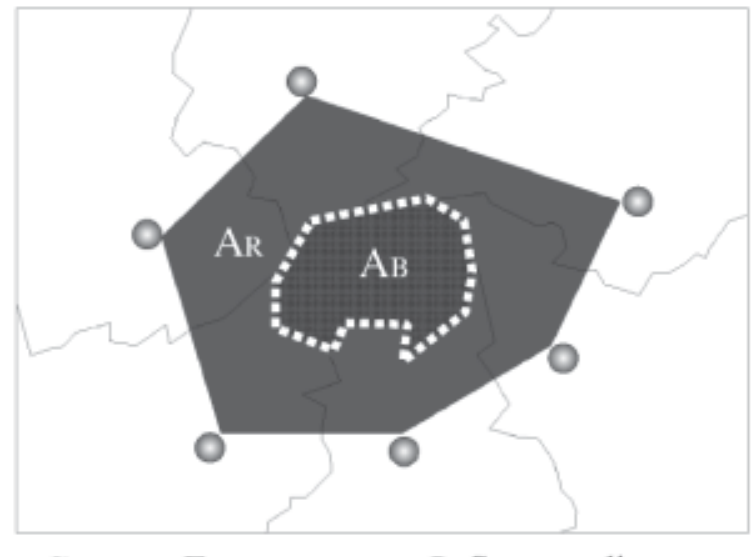
Fig. 1. Illustration of the ground projection of a canopy gap. The area of the vertical projection of the opened cano- py (A ) is found inside the area B which extends to the line link- ing the stems of the surround- ing canopy trees (A ; the sur- R rounding tree canopies are represented by the thin lines). Note, however, that A ex- B tends down to two m above the